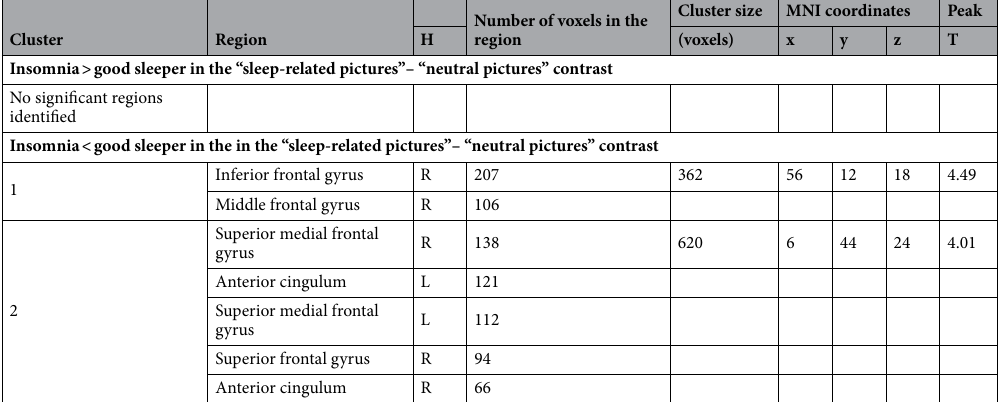
Cluster size MNI coordinates